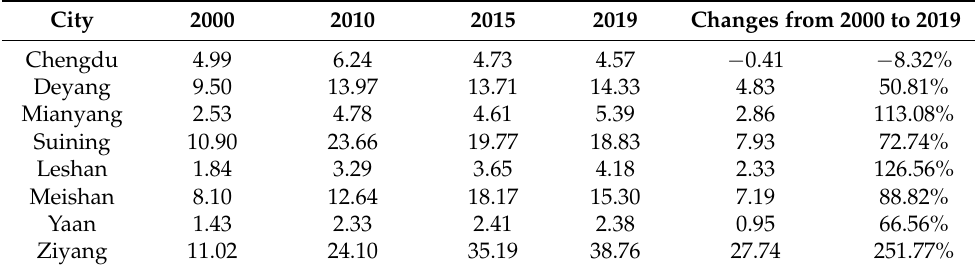
Table 5. Per capita 3D ecological footprint from 2000 to 2019 (hm 2 ).